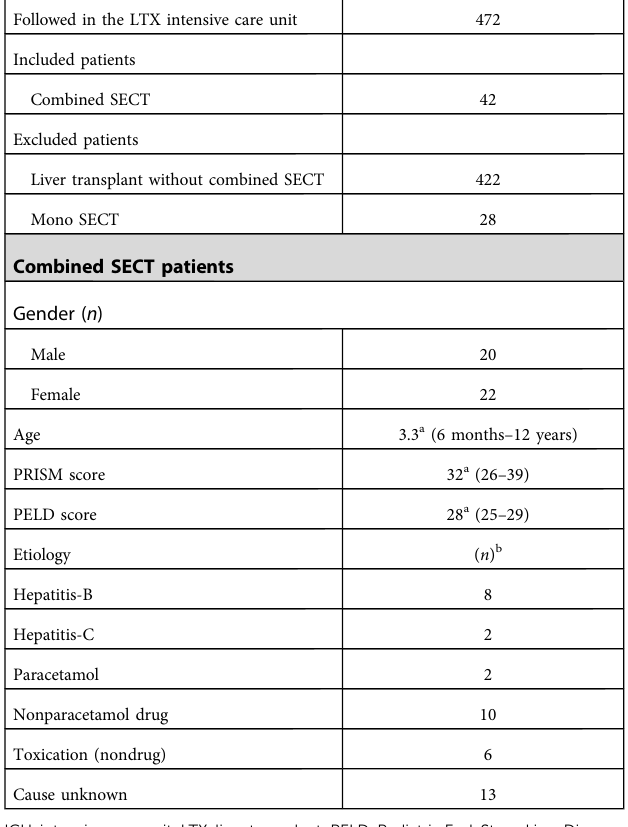
TABLE 1 Data of pediatric patients at the time of admission to the transplant ICU. Followed in the LTX intensive care